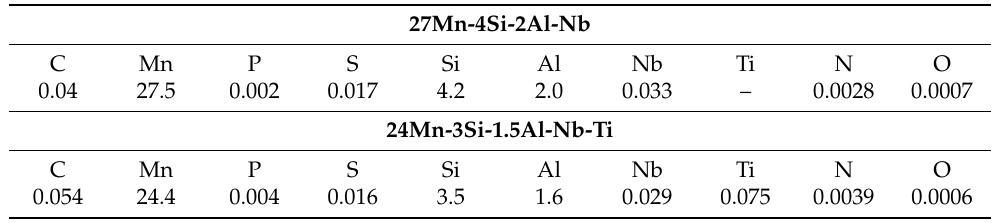
Table 1. Chemical compositions of investigated